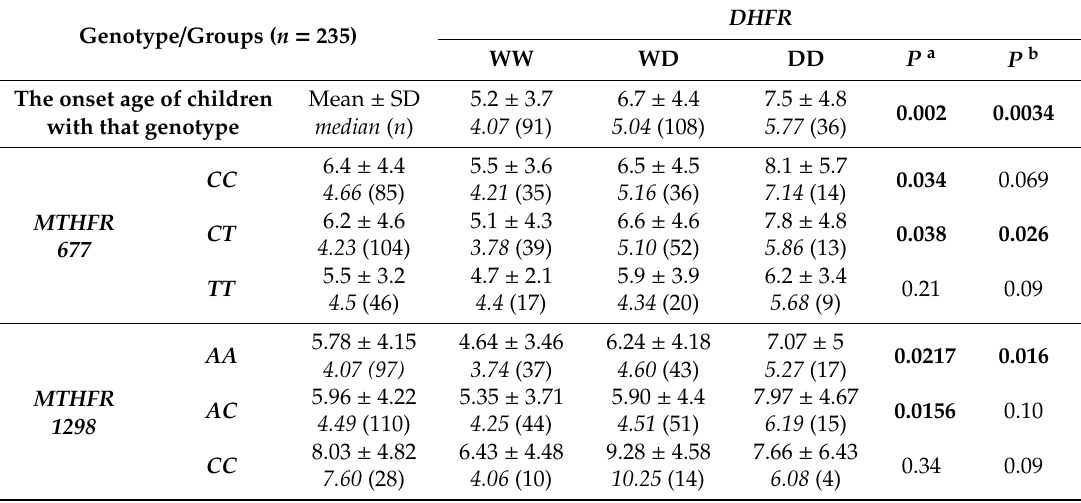
Table 3. Age of ALL onset according to di ff erent combinations of children genotypes. Genotype / Groups ( n = 235)